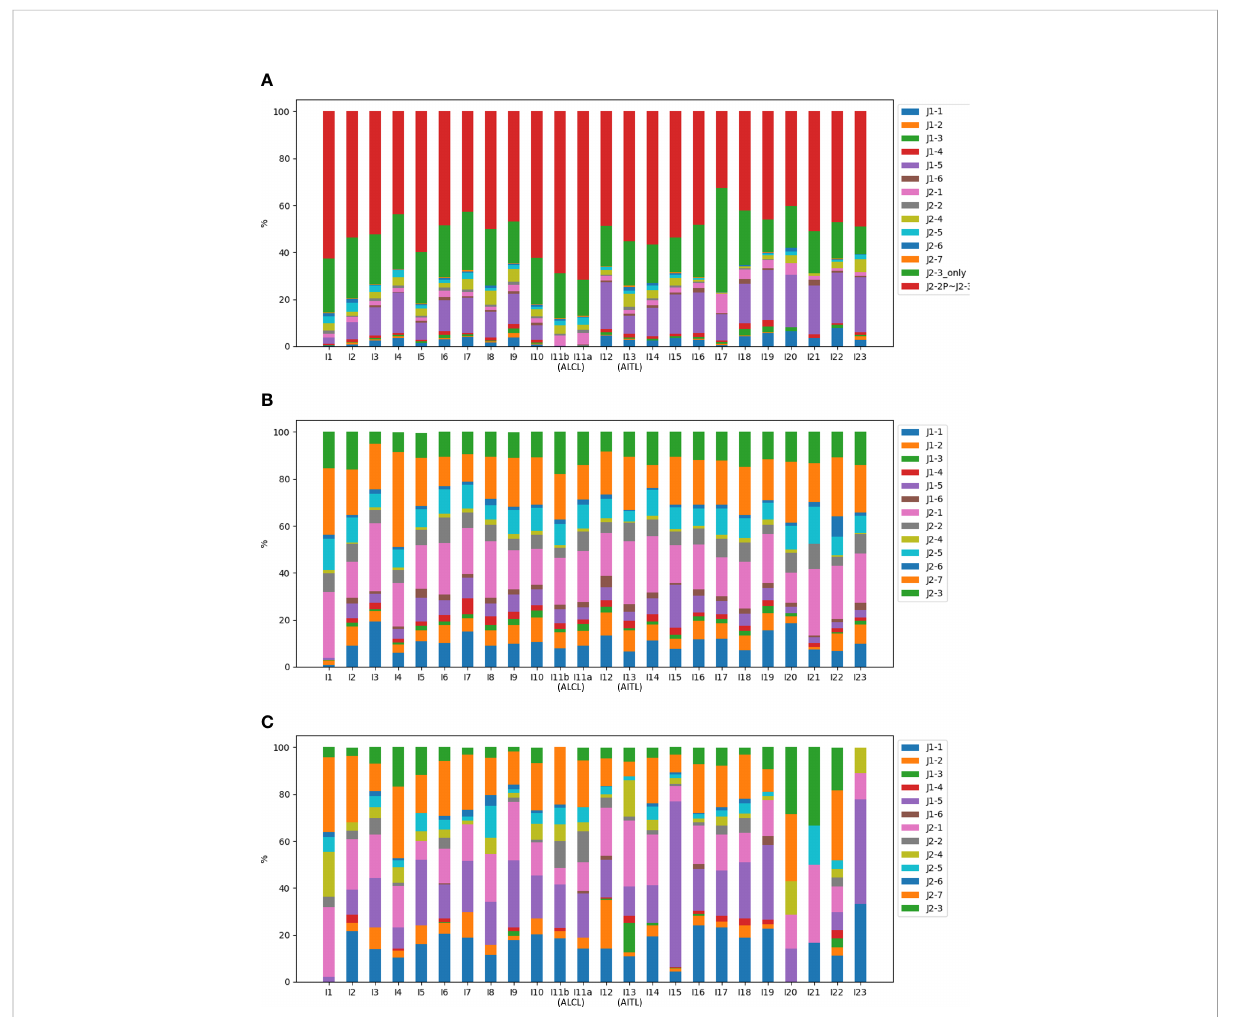
FIGURE 4 Compositions of the J gene segments in (A) NR, (B) CR, and (C) PR reads of all samples. In (A) , the J2-3 reads are divided into J2-2P~J2-3 and J2-3_only